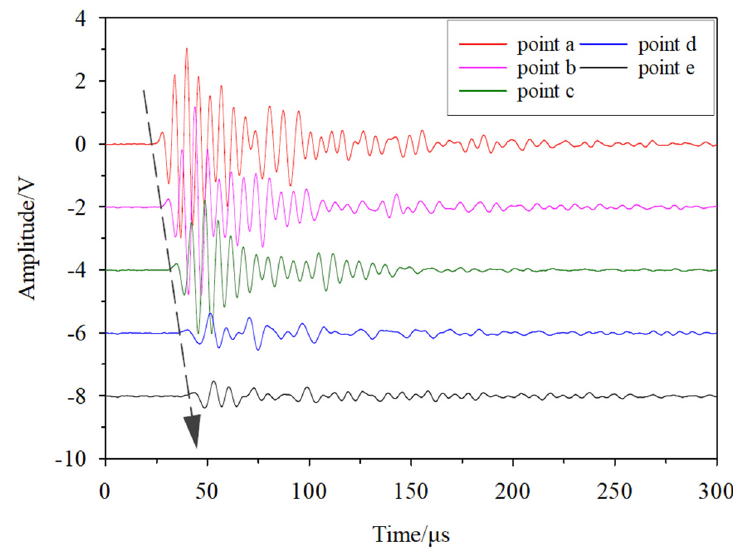
Figure 4. Variation characteristics of acoustic waveforms at selected points during hydrate dissoci- ation.